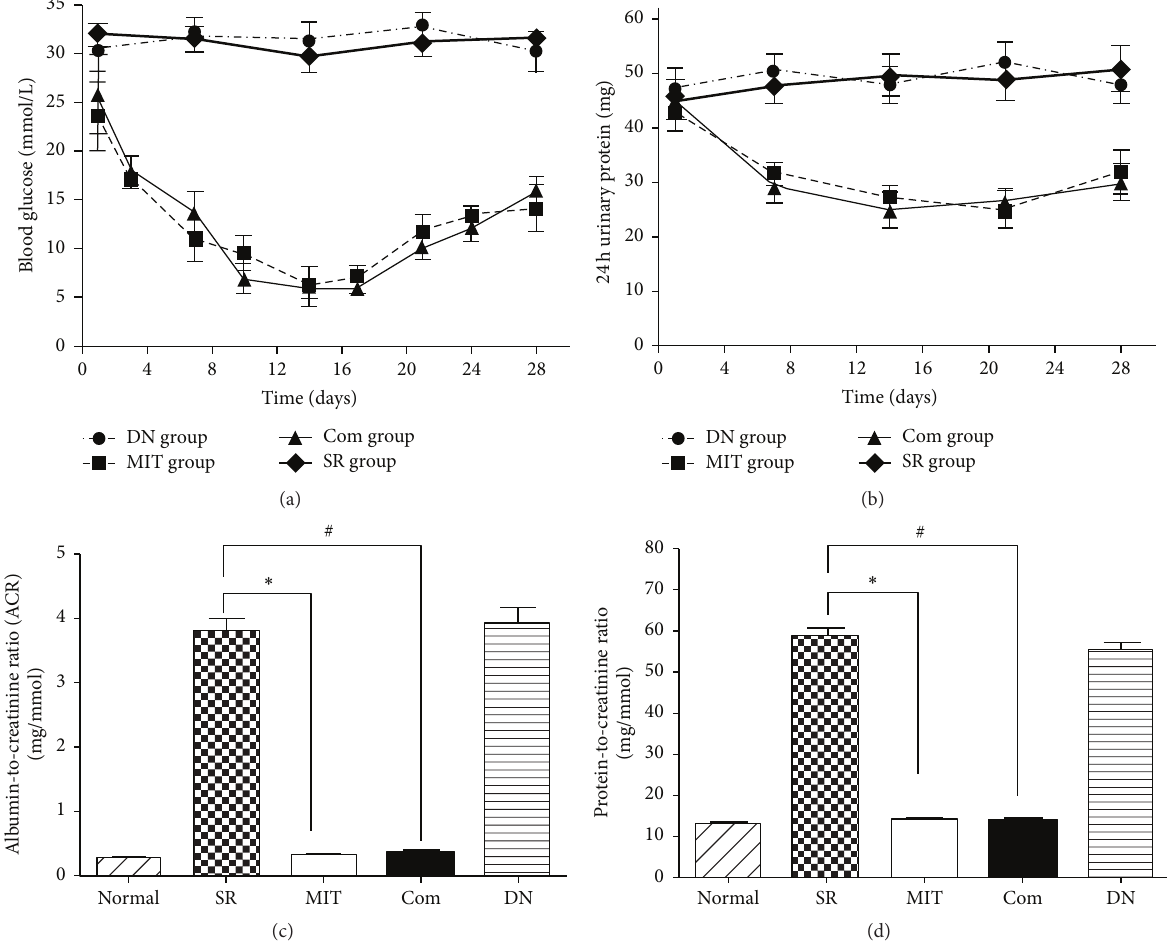
Figure 2: Blood glucose levels and urine analysis. After microencapsulated islet transplantation, the blood glucose level (a) and 24-hour urinary protein (b) were decreased significantly. ∗ 𝑃 < 0.01 , MIT group compared with the SR group; # 𝑃 < 0.01 , Com group compared with the SR group. (c) Urine albumin-to-creatinine ratio in each group; ∗ 𝑃 < 0.001 and # 𝑃 < 0.001 . (d) Urine protein-to-creatinine ratio in each group; ∗ 𝑃 < 0.001 and # 𝑃 < 0.001